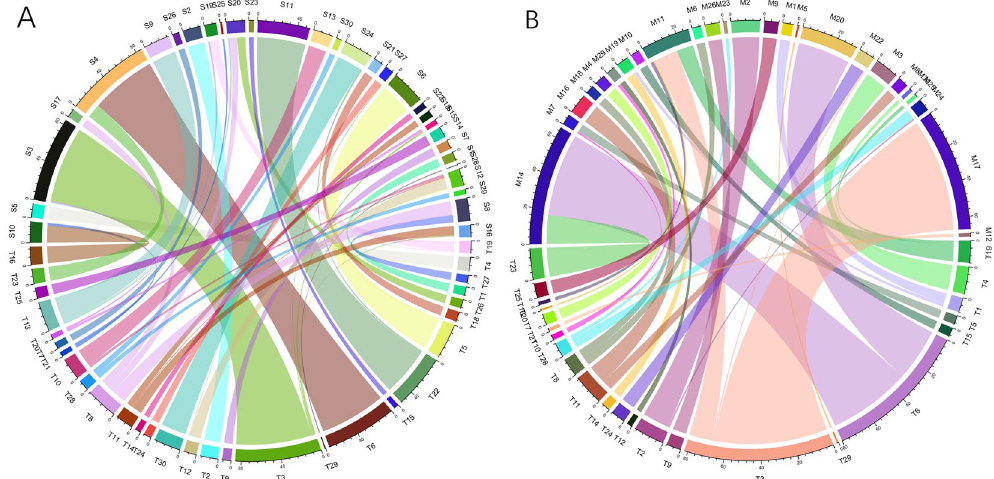
Figure 2. Comparison of collaborative subnetworks derived from SSGA or MSGA with those derived from Triple-Link Algorithm. ( A ) Comparison of the top 30 subnetworks derived from SSGA and Triple-Link Algorithm. The name of each subnetwork derived from SSGA is prefixed with “S,” whereas the name of each subnetwork derived from Triple-Link Algorithm is prefixed with “T”. Each curved line links the same gene in the two subnetworks derived from the two algorithms. ( B ) Comparison of the top 30 subnetworks derived from MSGA and Triple-Link Algorithm. The name of each subnetwork derived from MSGA is prefixed with “M,” whereas the name of each subnetwork derived from Triple-Link Algorithm is prefixed with “T”. Each curved line links the same gene in the two subnetworks derived from the two algorithms. Note that for the sake of clarity, only the common genes shared by two subnetworks generated with different algorithms are